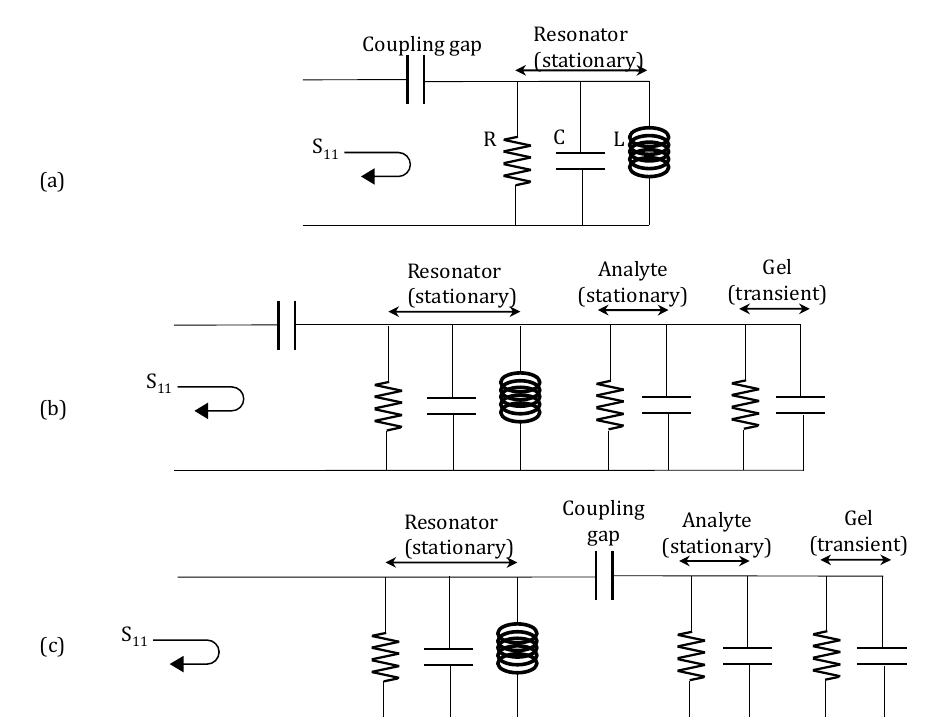
Figure 14. Circuit model of hydrogel sensing with microwave. ( a ) Circuit model of the microstrip microwave resonator; ( b ) Circuit model of the resonator, analyte and hydrogel of the hydrogel sensor with contact-mode microwave readout; ( c ) Circuit model of the probe, analyte and hydrogel of hydrogel sensing with remote microwave readout.